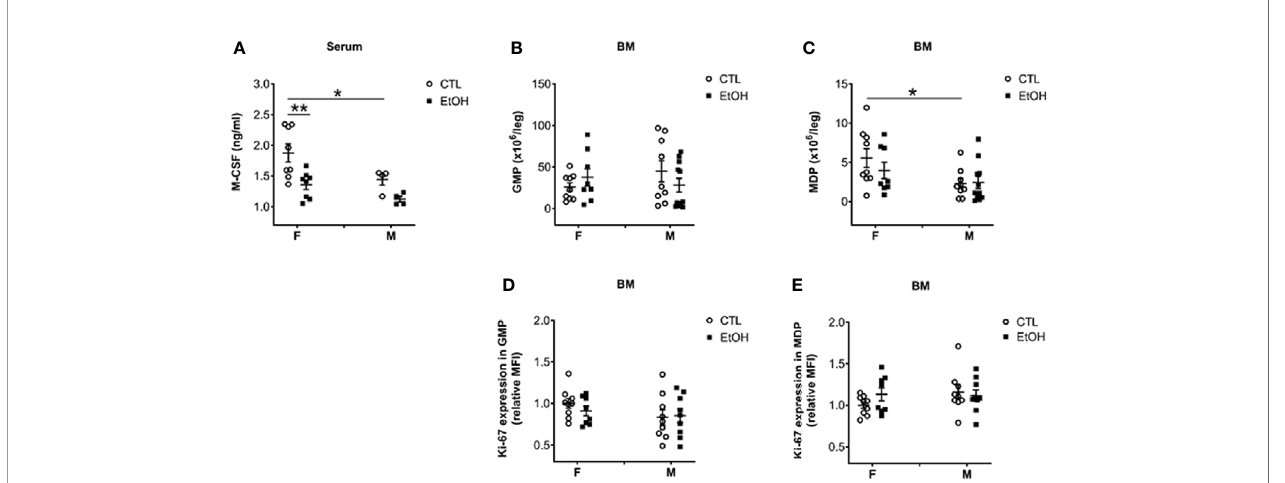
FIGURE 2 | Alcohol consumption reduced M-CSF serum level in female mice but did not change the numbers nor the proliferation of classical BM progenitors. Female (F) and male (M) from wild type (WT) mice were provided a regular chow diet and ethanol in drinking water (EtOH) or ethanol-free water (CTL). After 4 weeks, mice were euthanized, and blood and BM collected. (A) Dot graphs showing the serum level of M-CSF. n ≥ 4. (B – E) BM cells counted then stained for fl ow cytometry analysis. BC) Dot graphs showing the numbers of GMP (B) and MDP (C) per leg. (D, E) Dot graphs showing Ki-67 expression (relative MFI) in GMP (D) and MDP (E) . n ≥ 8. Values are showing the mean ± SEM, *p<0.05,